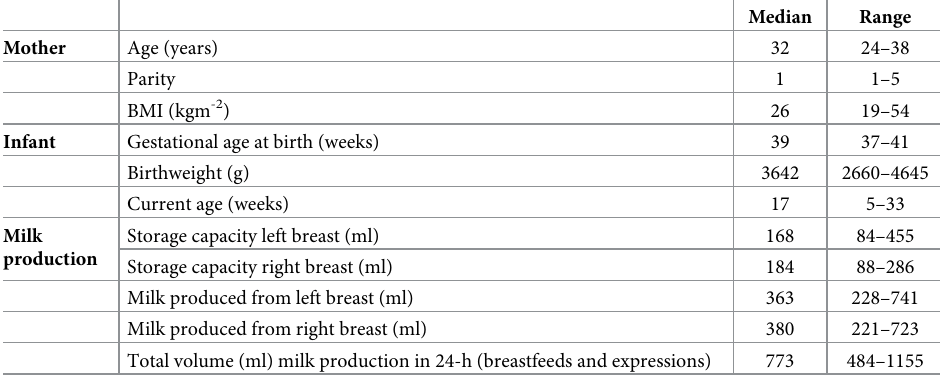
Table 1. Maternal and infant characteristics in 30 mother-infant